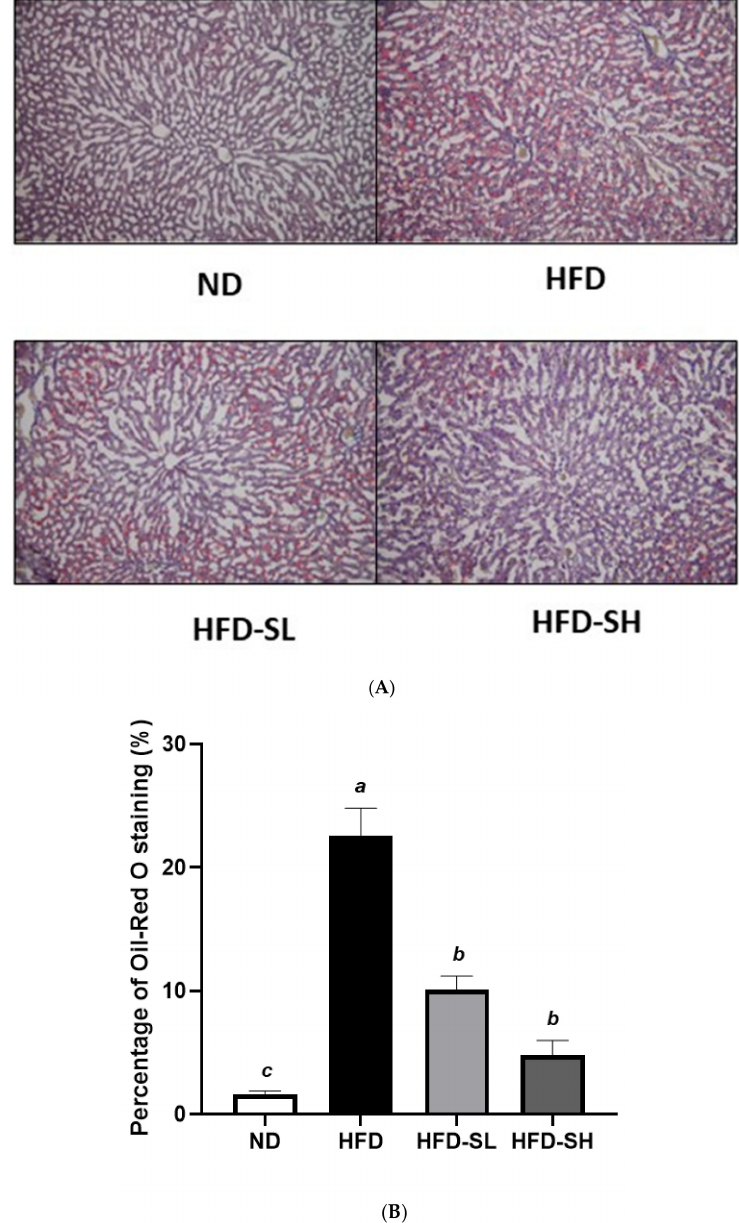
Figure 4. E ff ect of Spergularia marina powder (SMP) supplementation on lipid accumulation in the liver. Livers from each experimental group were harvested, fixed, and stained with Oil Red O. ND, Normal diet; HFD, High-fat diet; HFD-SL, High-fat diet + 3% of Spergularia marina Griseb; HFD-SH, High-fat diet + 5% of Spergularia marina Griseb. HFD induces numerous and larger lipid droplets; SMP supplementation inhibits lipid accumulation. ( A ) Representative figures from each group. ( B ) The quantification of A. Values are means ± SDs, n = 8. Data were analyzed by one-way ANOVA using Kruskal–Wallis analysis followed by Tukey’s post hoc test. Means labeled without a common letter di ff er, p <